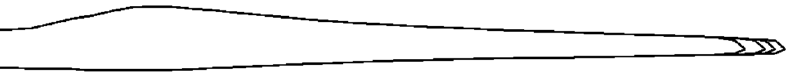
Figure 2. Shape of the original and modified blades.